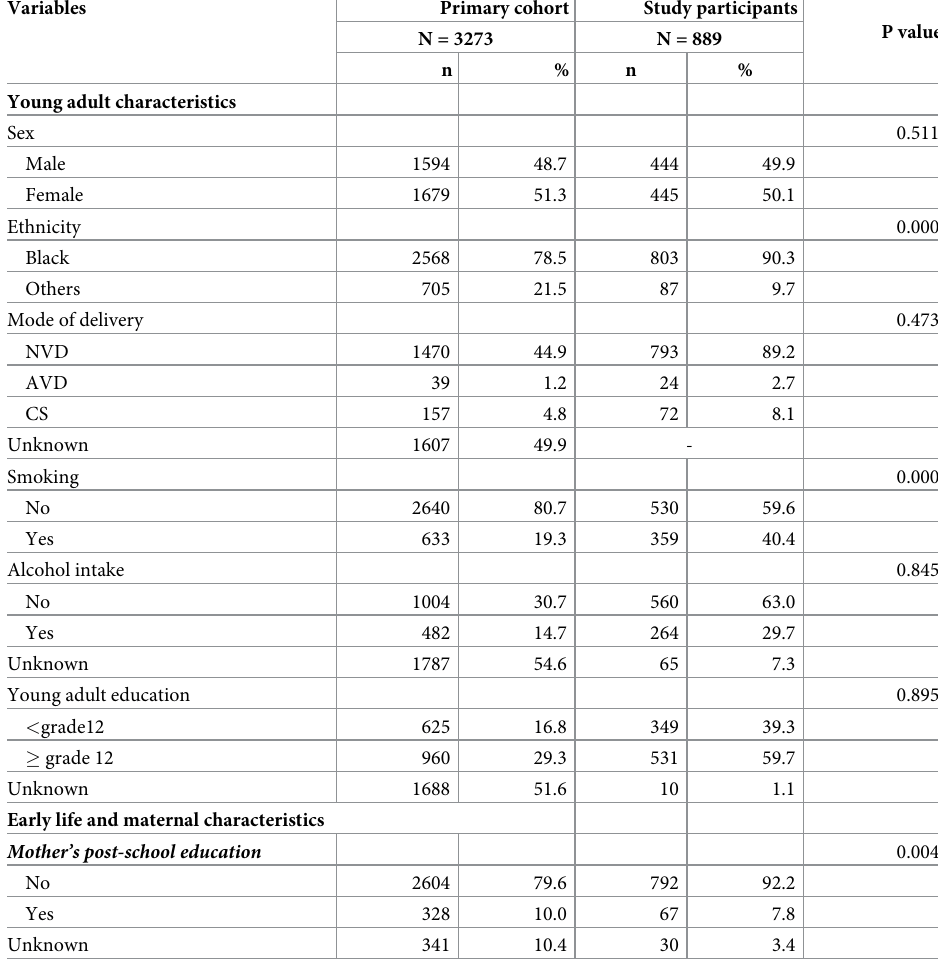
Table 1. Comparison between primary cohort and study participants (categorical variables).